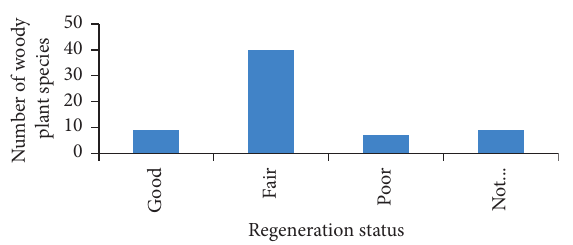
Figure 8: The regeneration status of woody plant species in Kenech